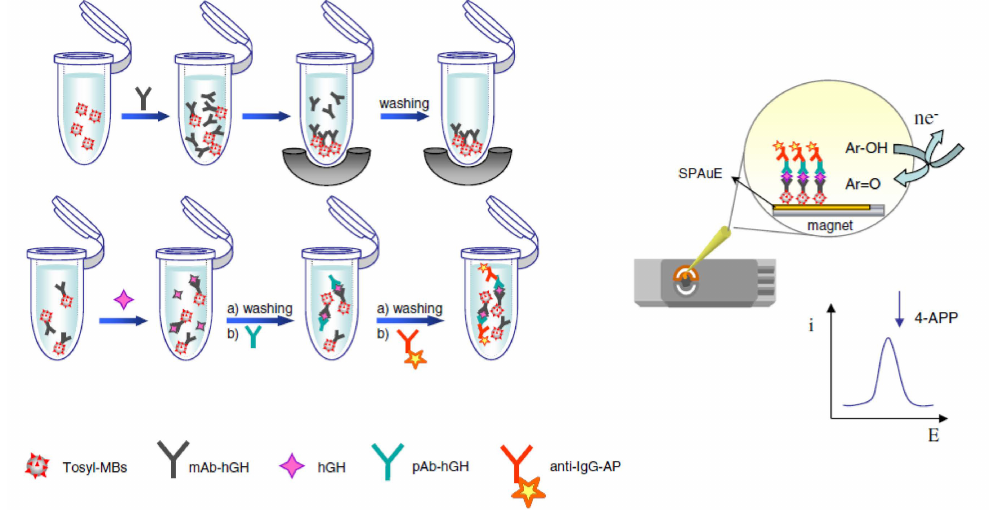
Figure 1. Scheme of the preparation and functioning of the disposable magneto-immunosensor developed for the determination of human growth hormone (hGH). Reprinted from Ref. [16] with